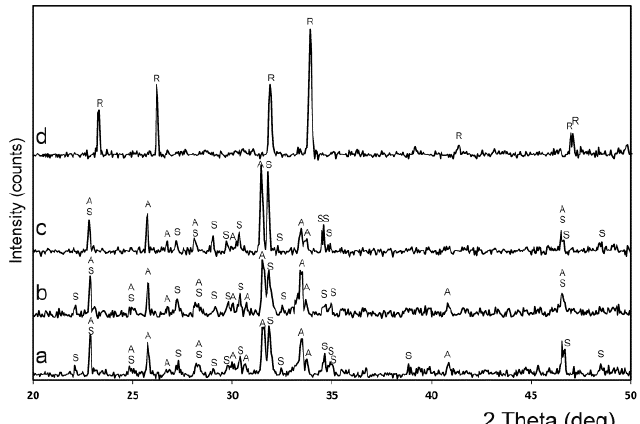
Figure 4. XRD patterns of samples ( a ) 55 wt % A/45 wt % S heated at 1250 °C; ( b ) 55 wt % A/45 wt % S heated at 1275 °C; and ( c ) 28.39 wt % A/71.61 wt % S, heated at 1362 °C; and ( d ) 28.39 wt % A/71.61 wt % S, heated at 1370 °C. (S: silicocarnotite ss ; A: Nurse’s A-phase ss ; R: ( α -C 2 S- α ´TCP) ss ).